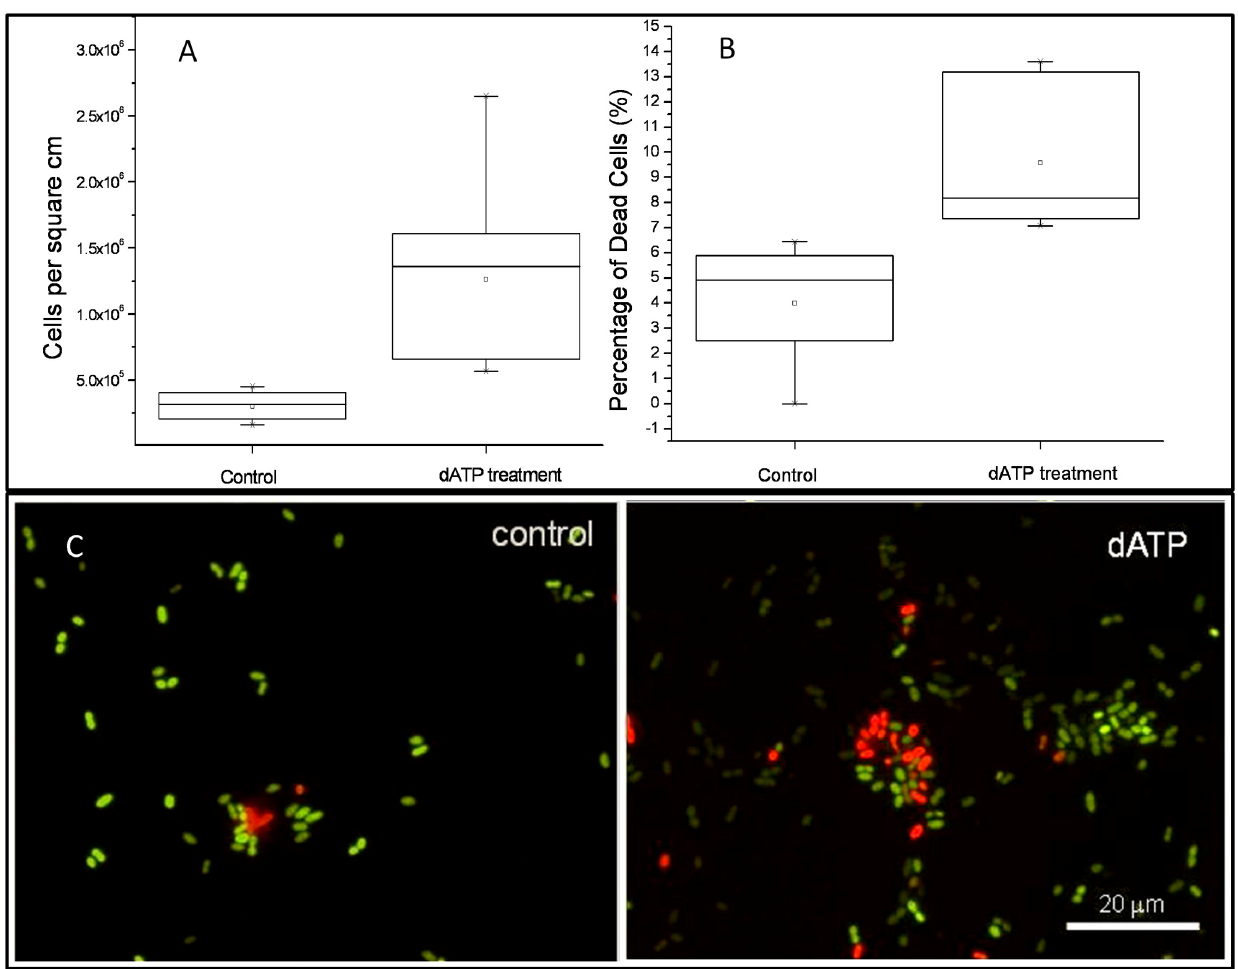
Figure 5. Quantification and fluorescent micrographs of cell attachment and cell lysis on glass surfaces of the E.coli strain. E. coli (1– 1.5 6 10 6 CFU/mL) was incubated in a petri dish with glass coverslips submerged in 10% LB supplemented with or without dATP (400 m M) at 30 u C with gentle shaking for 2 hours. Coverslips were stained with Bacterial Live/Dead staining dyes before being observed under an epi-fluorescent microscope. A, number of bacterial cells attached to the glass surfaces; B, percentage of dead or membrane damaged cells; C, Representative micrographs shown attached live cells (green) and dead cells (red).